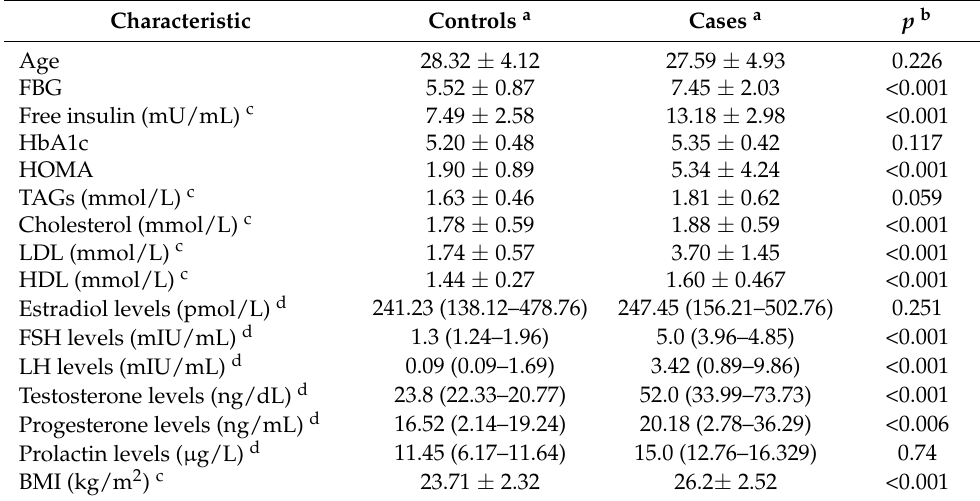
Table 2. Comparative biochemical profiling of patients and controls. Characteristic Controls a Cases